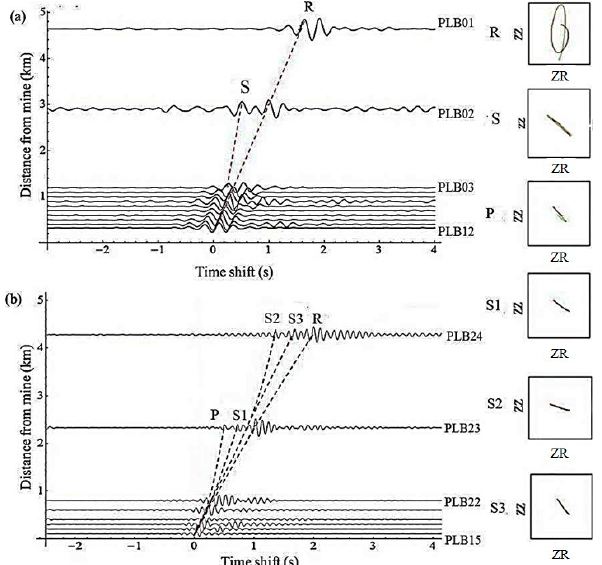
Figure 9. Result of stacking and particle analysis of the EGF, eval- uated in the Pyhäsalmi experiment: (a) western part of the profile in the frequency band 2–5Hz; (b) eastern part of the profile in the frequency band 5–10Hz.